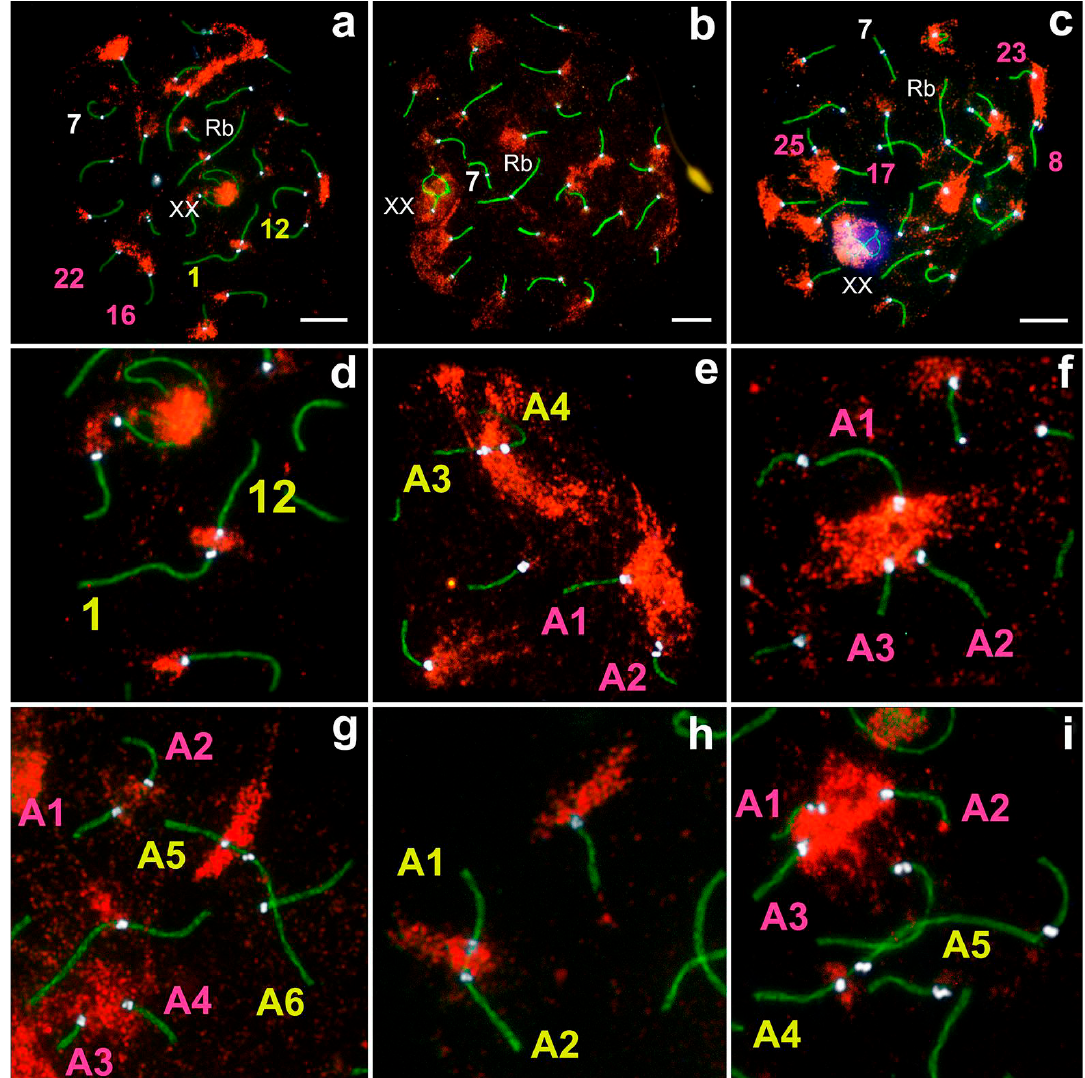
Figure 6. Location of SYCP3 (green), H3K9me3 (red), CREST (white) and gamma-H2AFX (violet) in the pachytene stage of prophase I of E. alaicus spermatocytes ( a – i ). Size bar = 5 µm ( a – c ). ( d ) an enlarged fragment of ( a ), ( e – i ) enlarged fragments of distinct cells. Designations A1–A6 do not correspond to numbers of chromosomes as in Figure 1. See the explanation in the text.